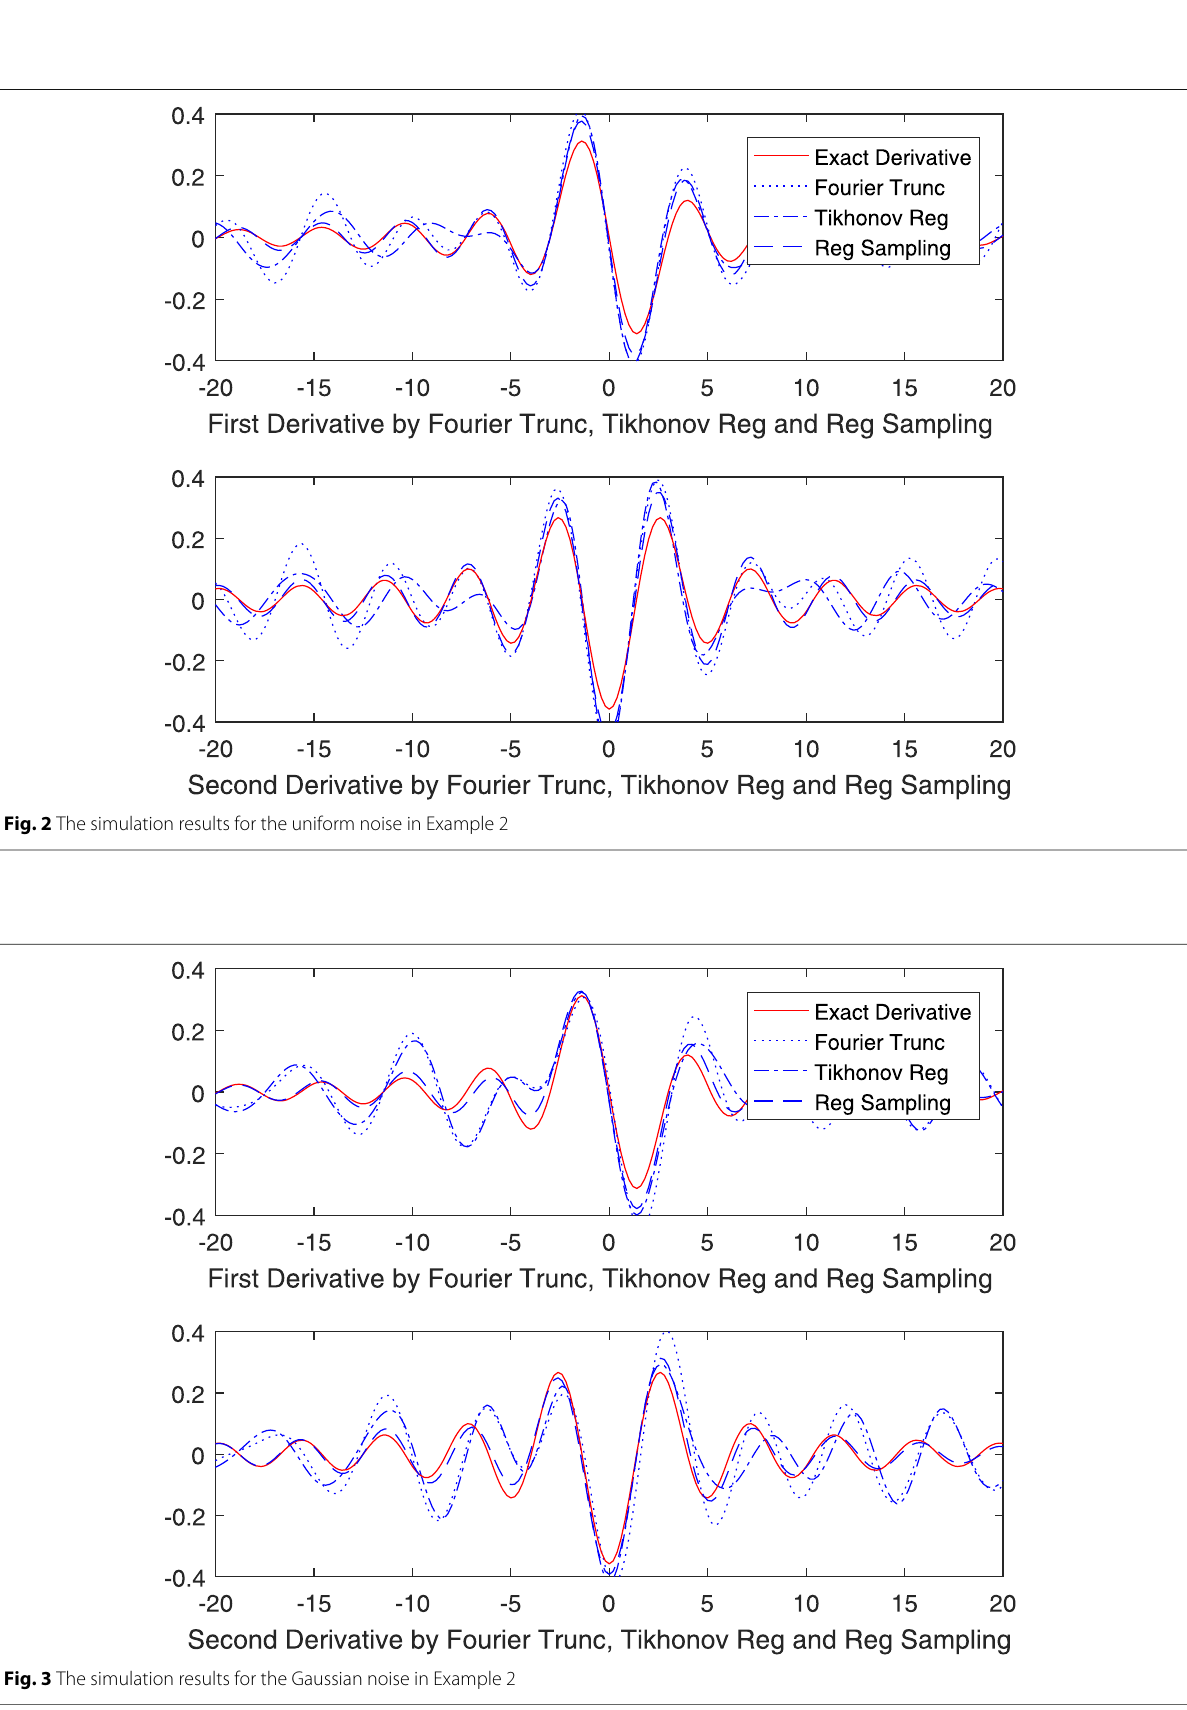
Fig. 3 The simulation results for the Gaussian noise in Example